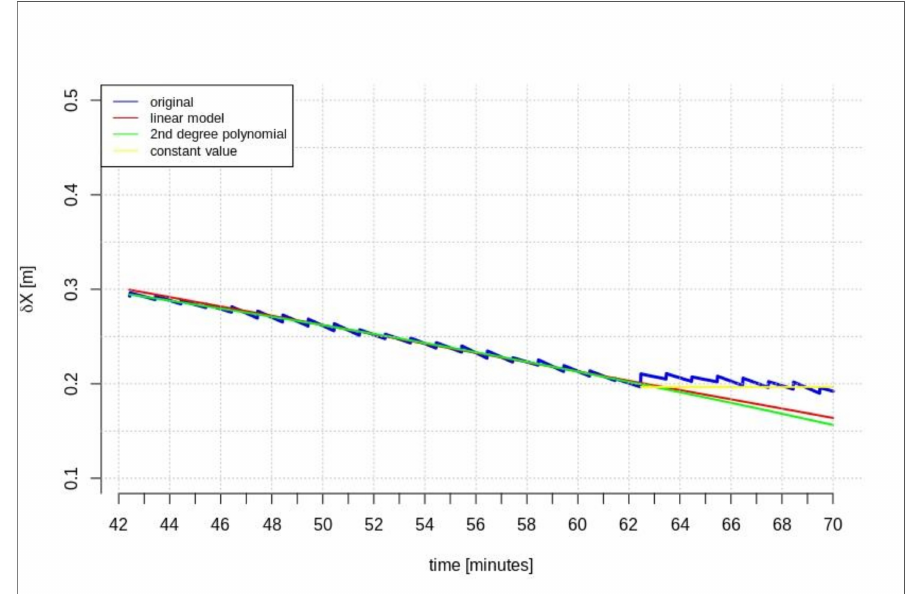
Figure 8. The results of the δ X geocentric correction extrapolation (GPS G13) for a 15 min data-stream—The time series of the orbit corrections refer to an out-of-date navigation